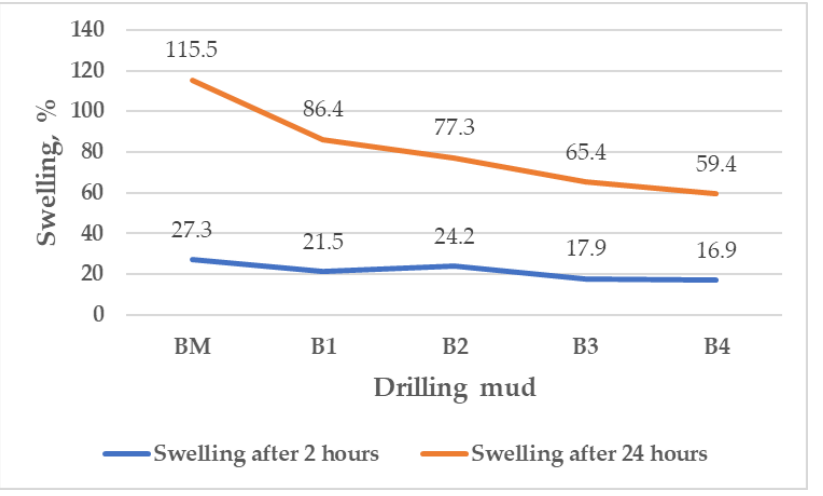
Figure 10. Pellet welling in base mud and in mud with added MPP (particles from 0.10 to 0.16 mm) within 2 and 24 h at 90 °C.